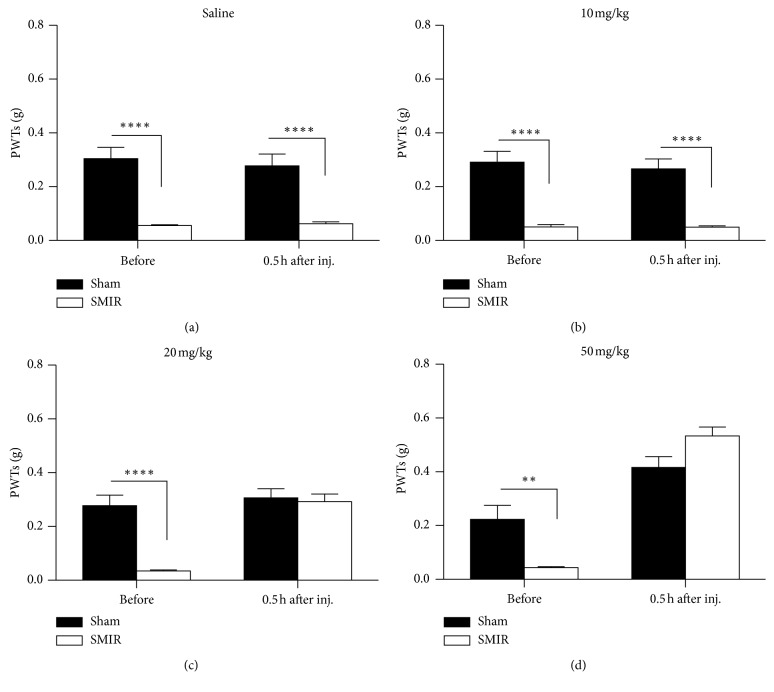
The application of gabapentin systemically raised the paw withdrawal threshold (PWT) in skin/muscle incision and retraction (SMIR) mice. (a) Saline had no effect on the PWTs in the sham and SMIR groups injected at day 4 after SMIR (two-way RM ANOVA, sham versus SMIR: F1; 17 = 35.83, P < 0.0001; treatments: F1; 17 = 0.55, P=0.47, interaction: F1; 17 = 1.74, P=0.20, n = 7 for the sham group; n = 8 for the SMIR group, ∗∗∗∗P < 0.0001 under Sidak's multiple comparisons test). (b) SMIR decreased the PWTs, which were not changed by the application of gabapentin at 10 mg/kg (two-way RM ANOVA, sham versus SMIR: F1; 17 = 71.68, P < 0.0001; treatments: F1; 17 = 0.25, P=0.63, interaction: F1; 17 = 0.19, P=0.67; n = 9 for the sham group, n = 10 for the SMIR group, ∗∗∗∗P < 0.0001 under Sidak's multiple comparisons test). (c) Gabapentin at 20 mg/kg increased the PWTs of the SMIR group (two-way RM ANOVA, sham versus SMIR: F1; 17 = 13.41, P=0.0019; treatments: F1; 17 = 57.53, P < 0.0001, interaction: F1; 17 = 36.69, P < 0.0001; n = 9 for the sham group, n = 10 for the SMIR group, ∗∗∗∗P < 0.0001 under Sidak's multiple comparisons test). (d) Gabapentin at 50 mg/kg increased the PWTs of both the SMIR group and sham group (two-way RM ANOVA, sham versus SMIR: F1; 9 = 0.73, P=0.41; treatments: F1; 9 = 102.7, P < 0.0001, interaction: F1; 9 = 19.41, P=0.0017; n = 5 for the sham group, n = 6 for the SMIR group, ∗∗P < 0.01 under Sidak's multiple comparisons test). ANOVA, analysis of variance; RM, repeated measures.